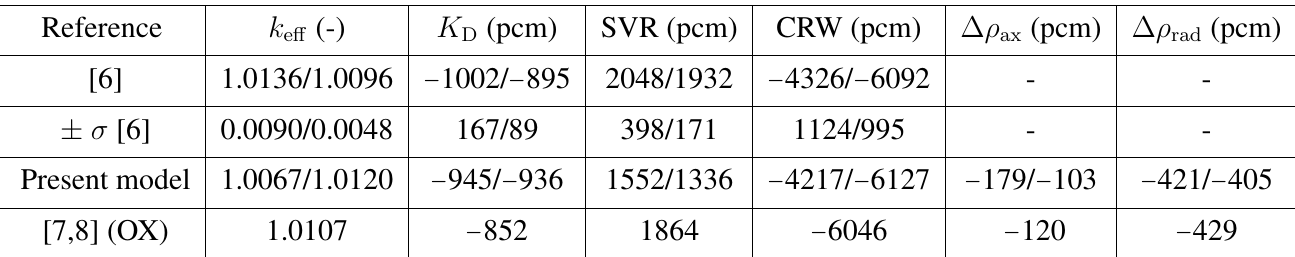
Table 2: 3D Full-Core Results for CA/OX Cores.